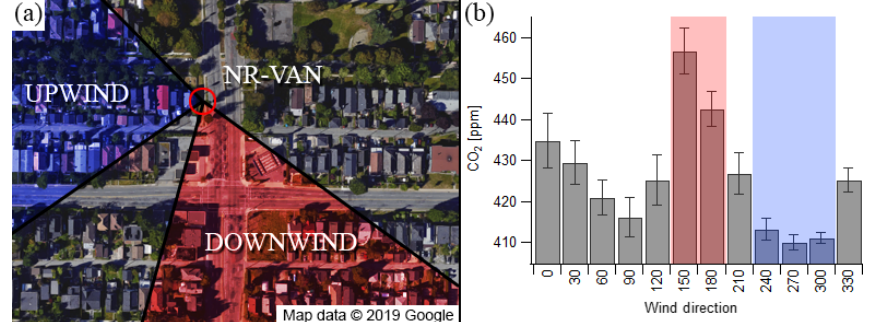
Figure 3. Satellite image of the NR-VAN site, along with upwind (blue) and downwind (red) sector definitions. Meteorological measurements were recorded on a 10m mast above the station’s location (labelled: NR-VAN) (a) . Average ambient CO 2 concentrations by wind direction, with upwind and downwind definitions again highlighted in blue and red, respectively. Error bars are 95% confidence intervals on the mean (b) .